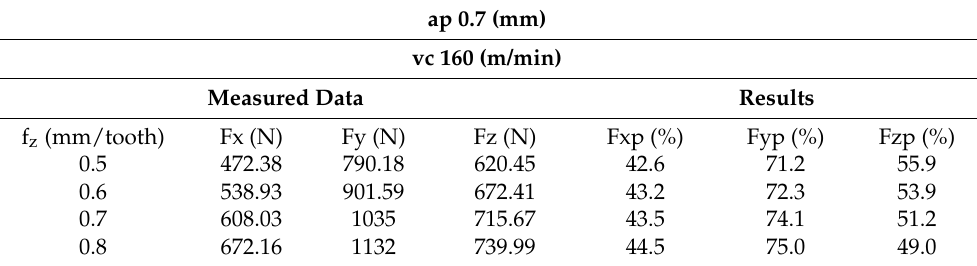
Table 9. Results for ap = 0.7(mm) and vc = 160 (m/min).